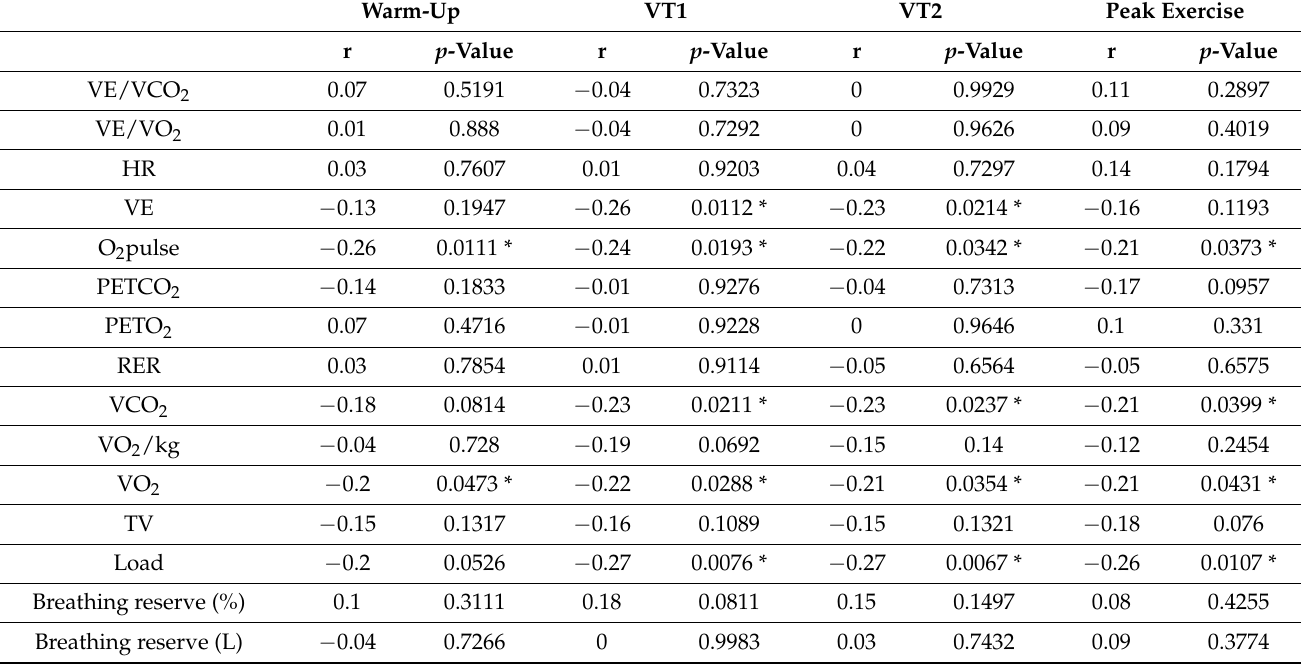
Table 2. Association of IF1 with CPET parameters during different stages of